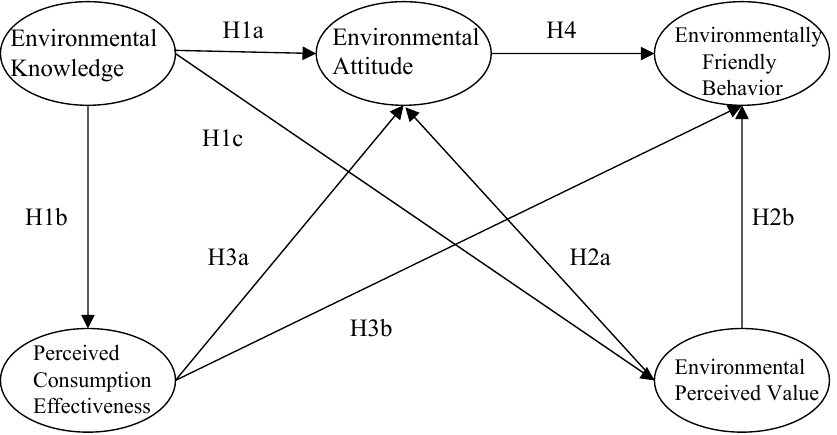
Figure 1. Research model themes and hypotheses (refer to the main text for hypotheses statements H1–H4).